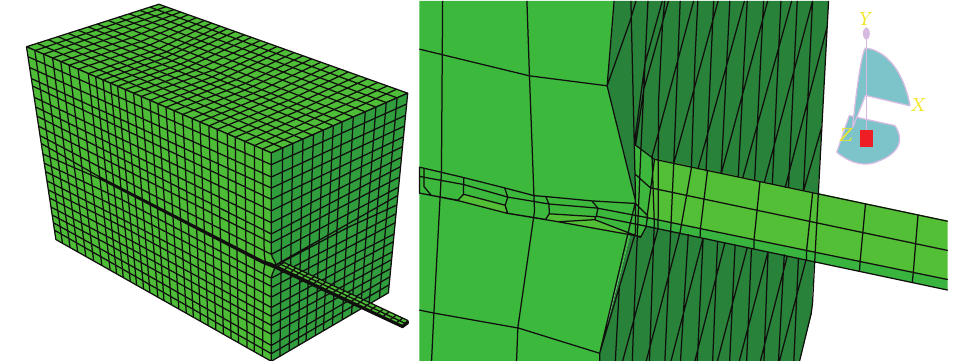
Figure 5: Deformation of FRP in this modeling.